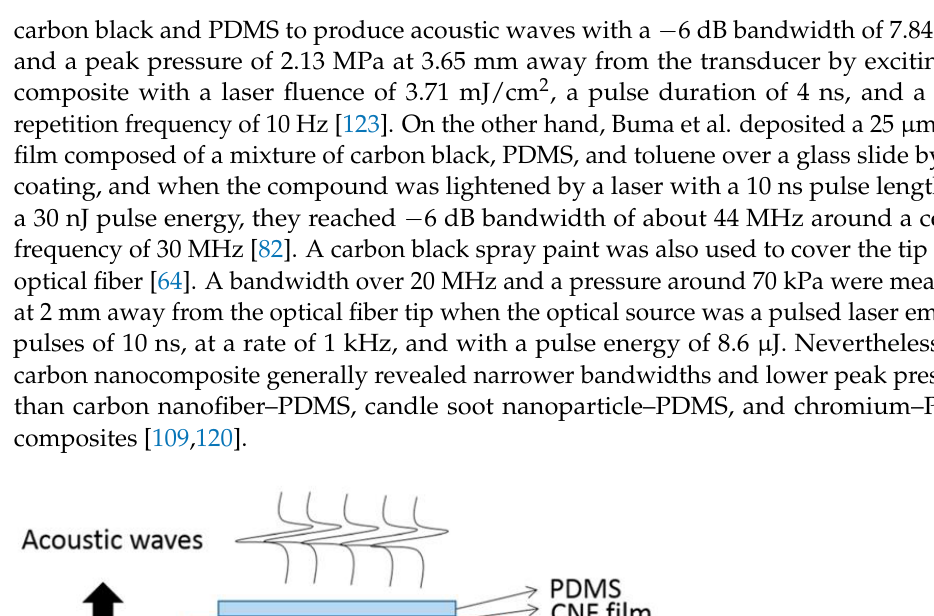
Figure 9. Organization of the carbon nanofibers and PDMS layers. Reproduced with permission from [123].